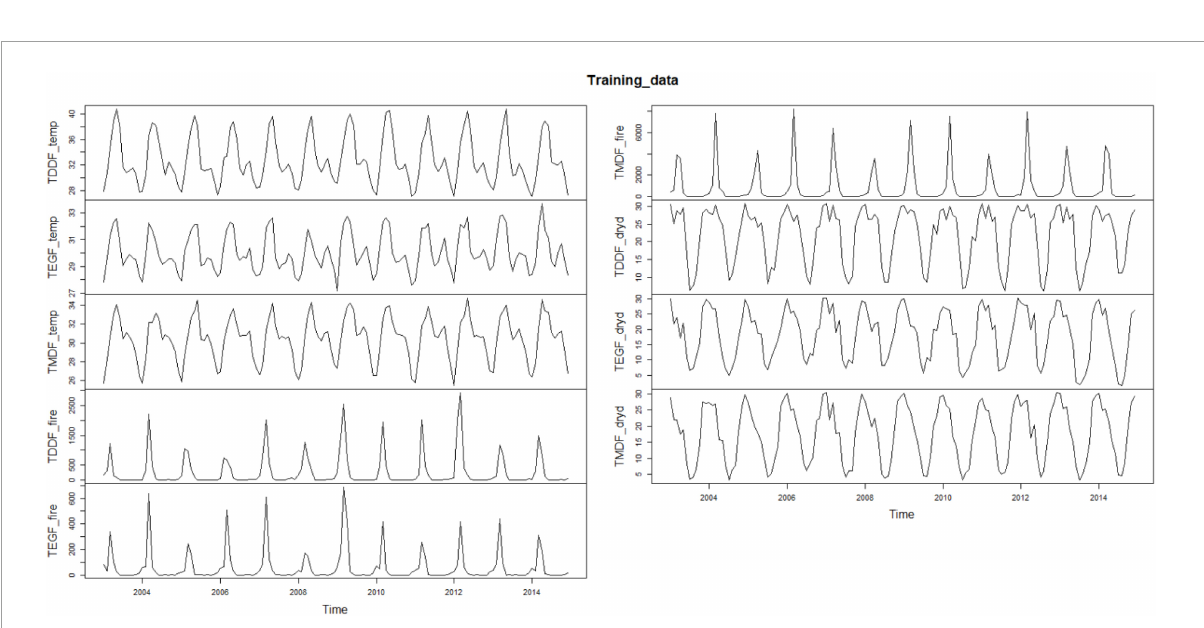
FIGURE2 Methodology.